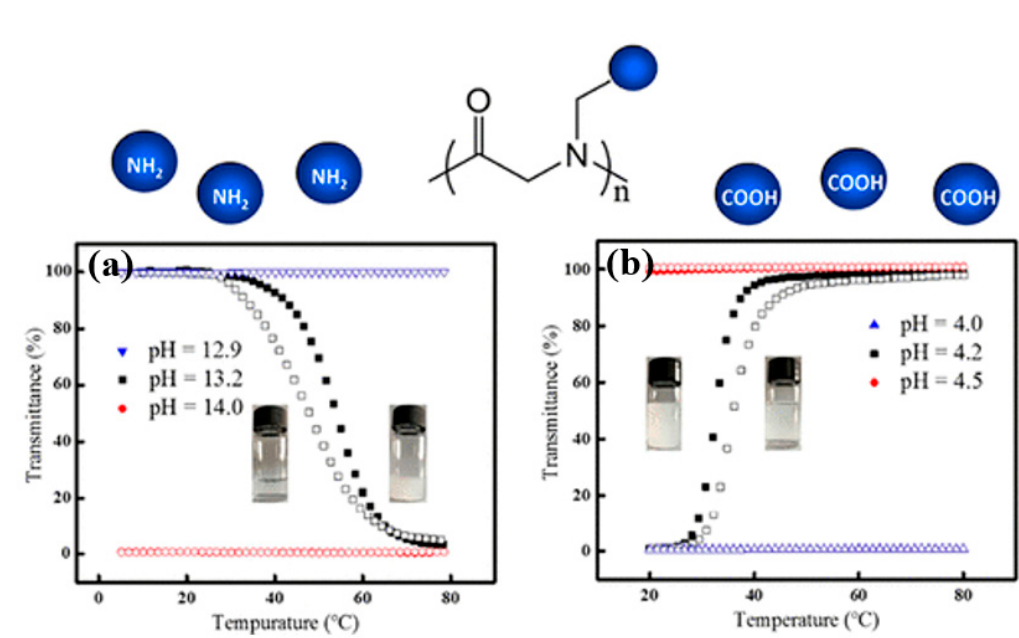
Figure 12. Plots of transmittance as a function of temperature for aqueous solutions ( a ) PNPG 41 -(COOH) 2 (2 mg/mL) at different pH. Filled symbol: cooling ramp; open symbol: heating ramp. ( b ) PNAG 79 -NH 2 (10 mg/mL) at different pH. Filled symbol: heating ramp; open symbol: cooling ramp. Reprinted with permission from [51] . Copyright 2018, American Chemical Society.